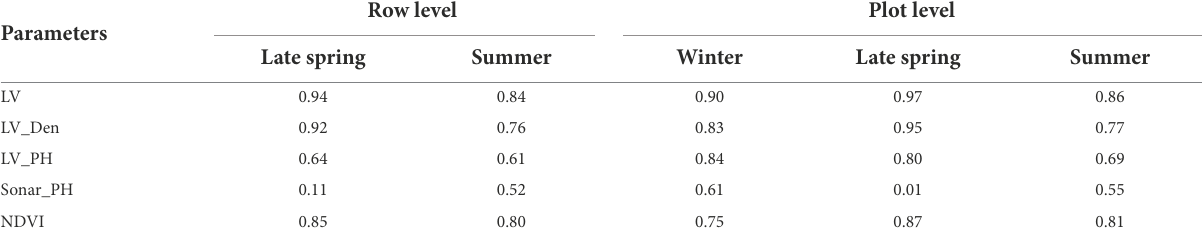
TABLE 2 A summary table of Pearson’s correlation coefficient (R) for the empirical relationship between each plant digital parameter and harvested fresh biomass in the seasonal dataset at the row and plot level.